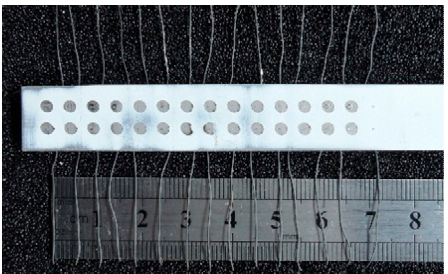
Figure 6. Photo of the through-hole lead connection. Table 4. Resistance measurement results.